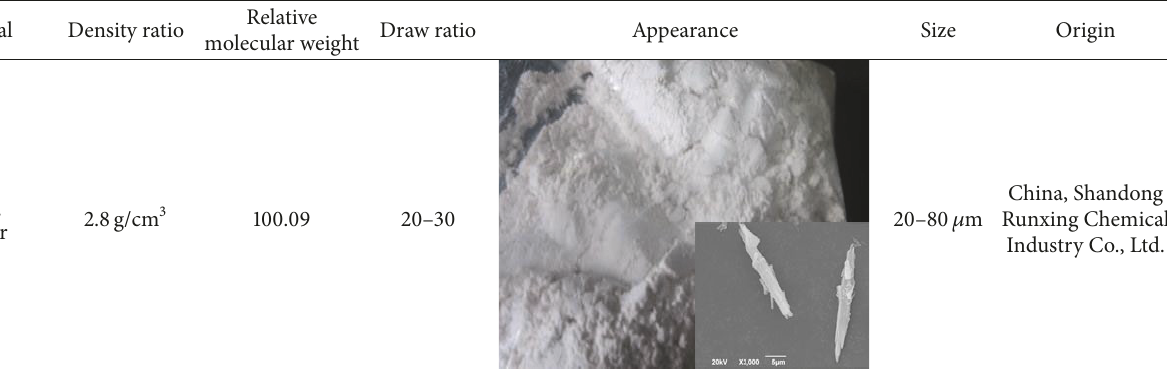
Table 1: Properties of CaCO 3 whisker.